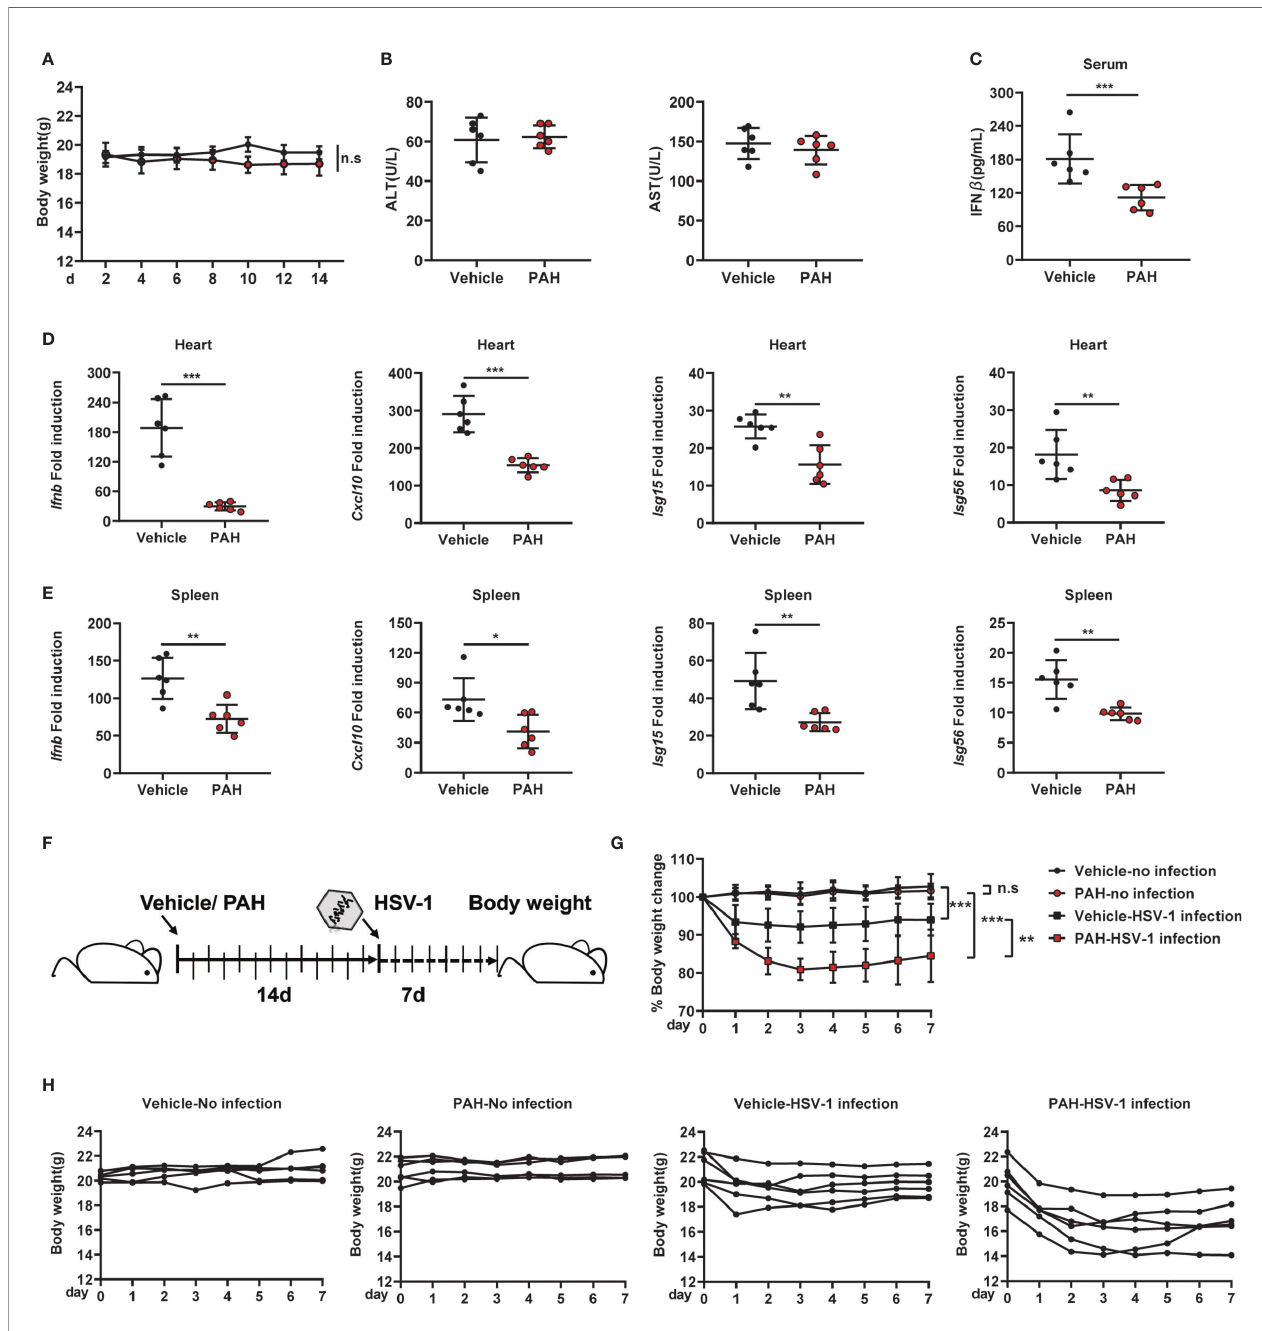
FIGURE 5 | PAH restricts the host innate defense against HSV-1 infection in vivo. (A) Mice were orally administered Vehicle (0.03% CMC-Na solution) or 120 mg (cid:129) kg − 1 PAH once per day for 14 days, then injected with HSV-1 intravenously. The time course of mice body weight. (B) Mice were orally administered Vehicle (0.03% CMC-Na solution) or 120 mg (cid:129) kg − 1 PAH once per day for 14 days, then the levels of aspartate aminotransferase (AST) and alanine aminotransferase (ALT) in serum were measured at the 14 th day. (C – E) Mice were treated as in (A) . The concentrations of serum IFN- b of mice were measured by ELISA (C) , and the levels of Ifnb , Cxcl10 , Isg15 , and Isg56 mRNA expression in the hearts (D) and spleens (E) of mice were measured by qPCR. (F) Schematic of drug administration and durable study after HSV-1 infection in vivo. (G) The time course of merged body weight from mice treated in (F) . (H) The time course of body weight from each mouse treated in (F) . Data in (A – E, G – H) are representative of two independent experiments (mean ± SD). n.s, no signi fi cance. * P < 0.05, ** P < 0.01, *** P <